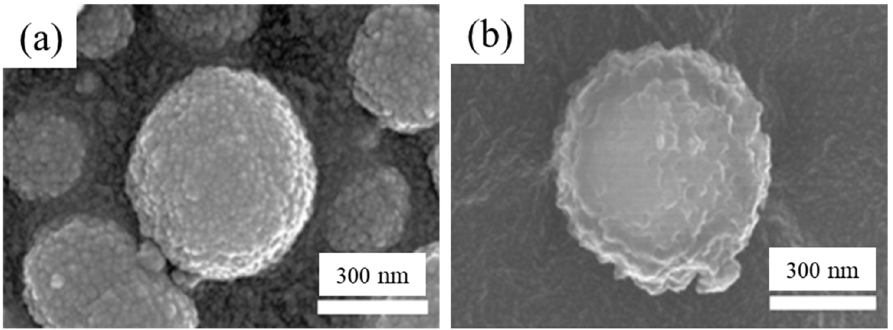
Figure 1. SEM photos of ( a ) the pure Fe 3 O 4 particles and ( b ) the Fe 3 O 4 /POA core–shell composite particles.